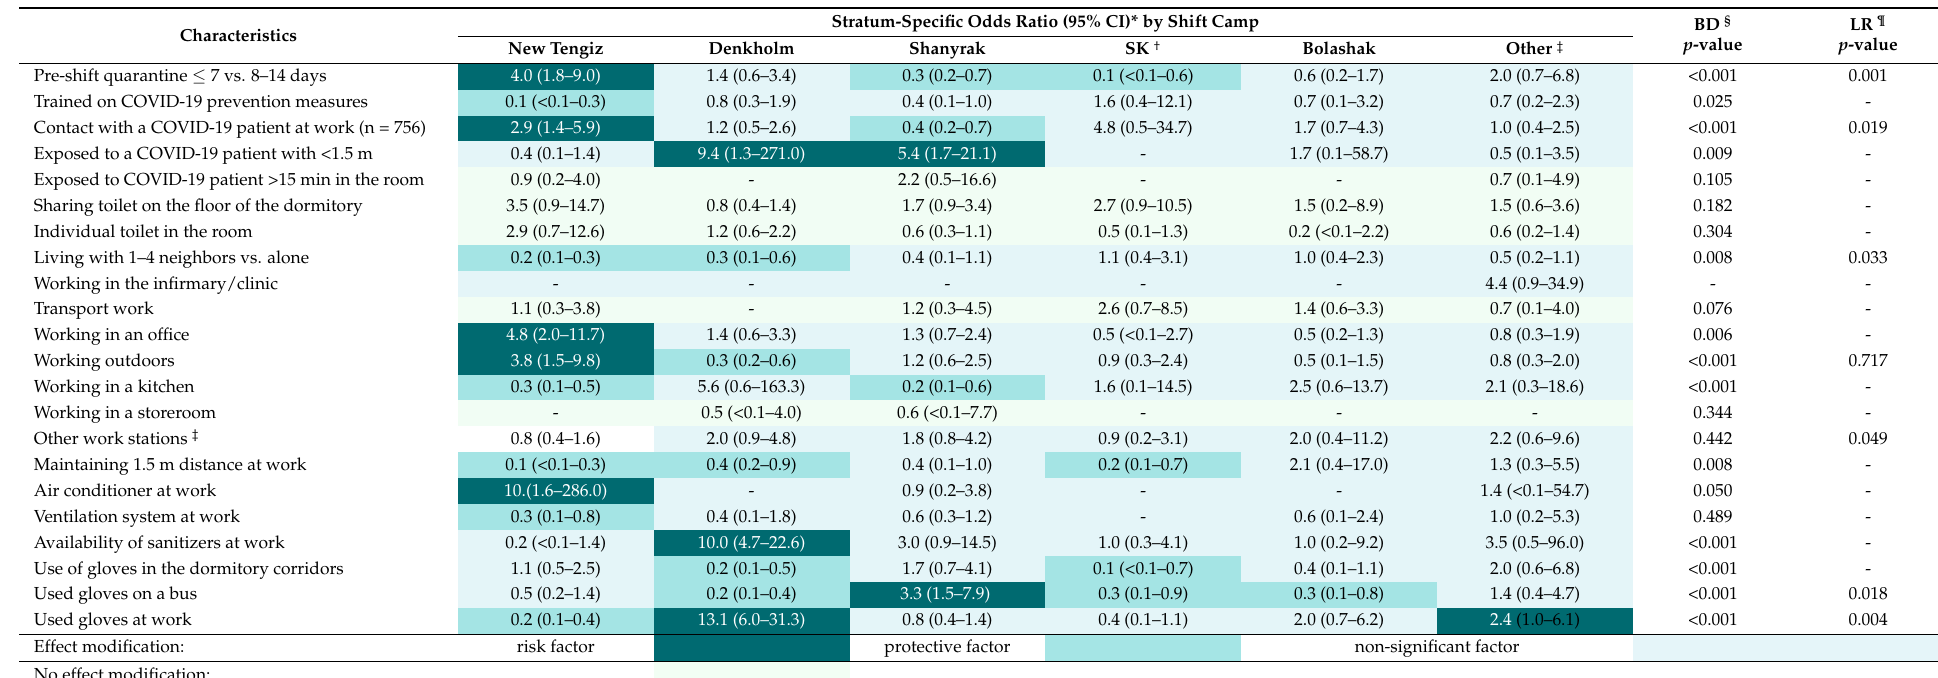
Table A2. Stratified analysis of environmental factors associated with novel coronavirus disease in Tengiz oil facility, assessing confounding and effect